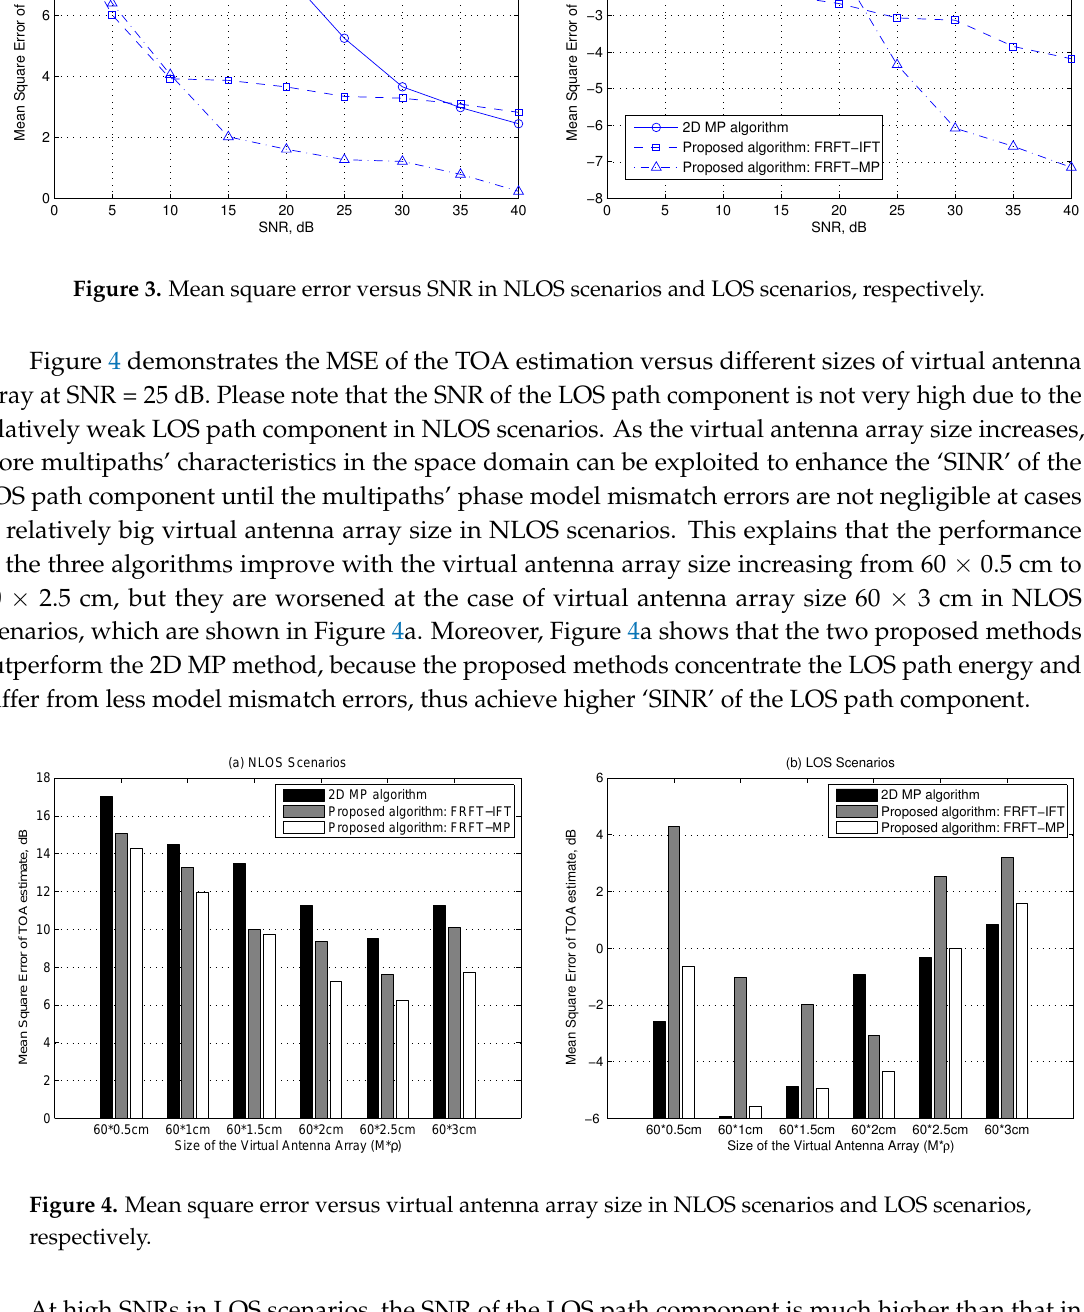
2D MP algorithm Proposed algorithm: FRFT−IFT Proposed algorithm: FRFT−MP